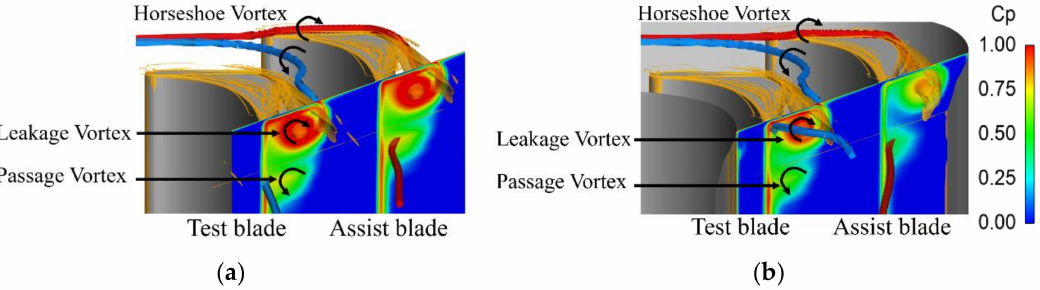
Figure 3. Three-dimensional flow structure at near tip region for ( a ) Periodic case and ( b ) 2-Passage